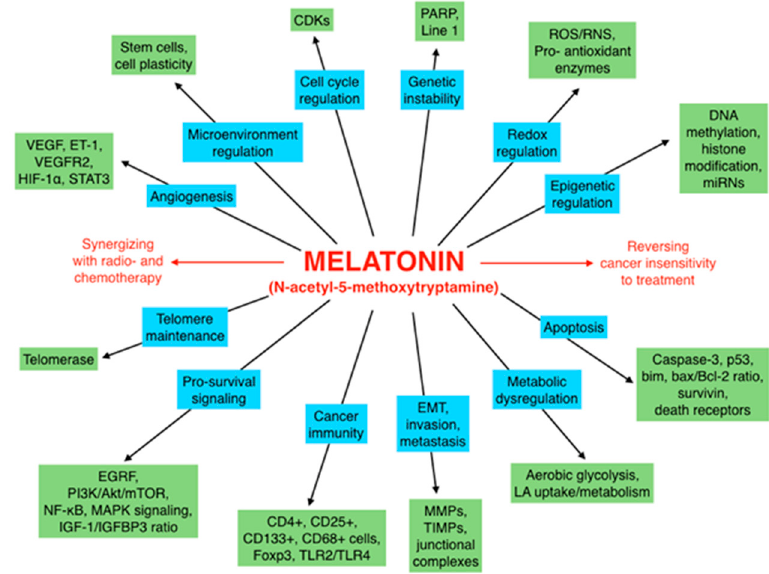
Figure 9. The multiple means that have been proposed by which melatonin may interfere with the growth of experimental tumors are listed. The blue boxes identify the process that are impacted by melatonin while the green boxes list the potential mechanisms involved. The information in red mentions the synergistic actions of melatonin with radio- or chemotherapies ( left ) and on the right it is noted that some cancers resistant to therapy can be made sensitive by treatment with melatonin.